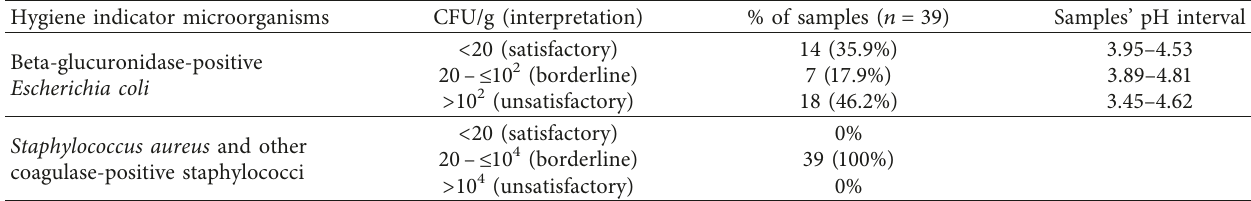
Table 1: Level of contamination by hygiene indicator microorganisms in raw vegetables salads served by roast meat eateries. Hygiene indicator microorganisms